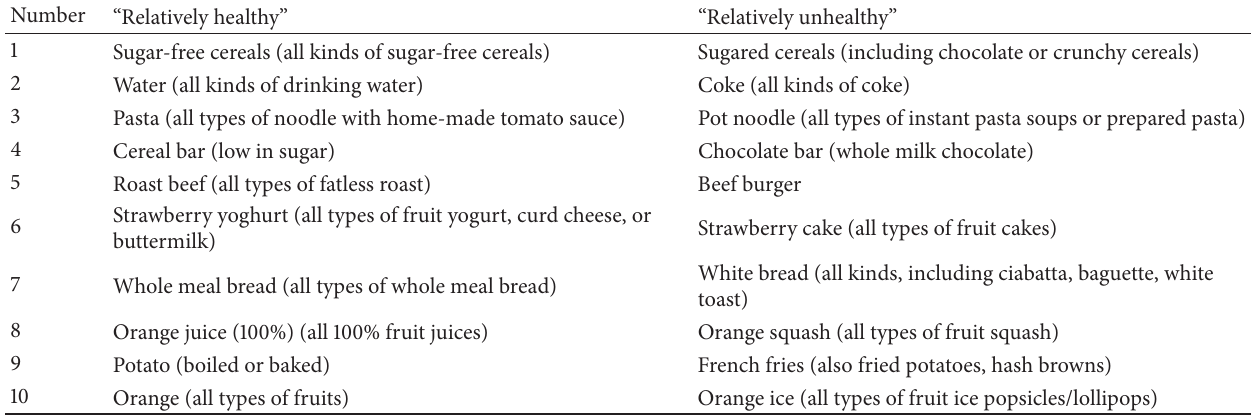
Table 1: Matched pairs of food cards based in part on Kopelman et al.